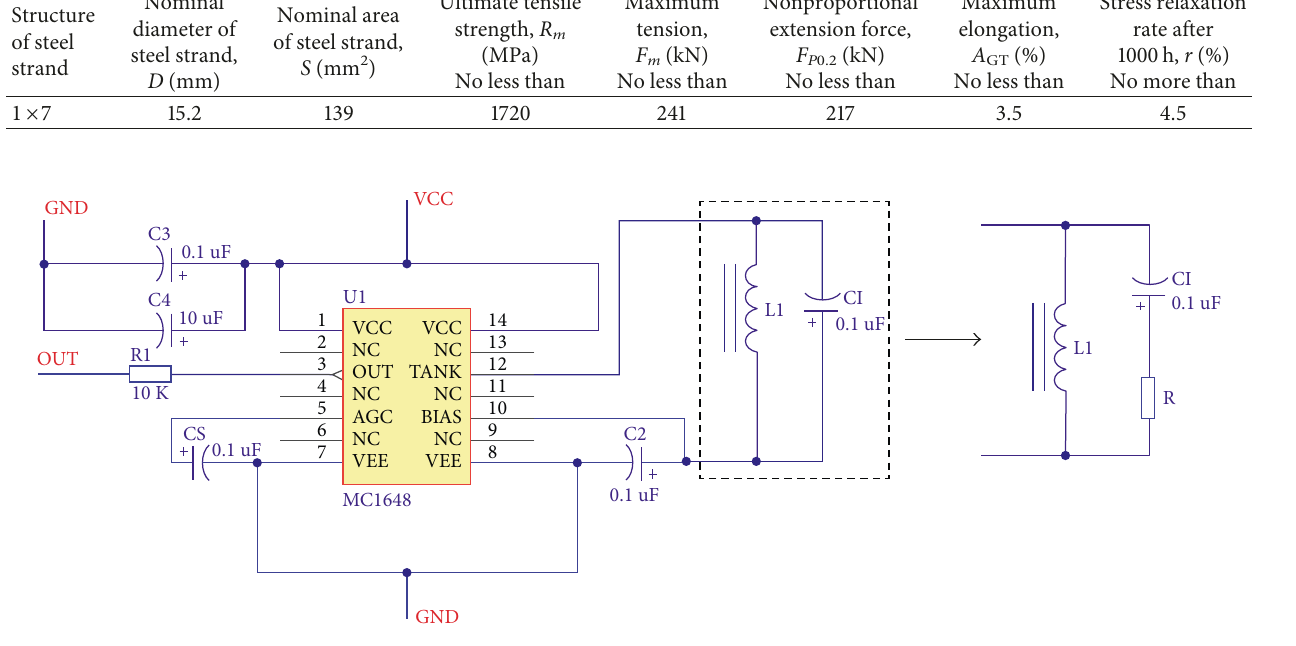
Figure 6: Circuit principle